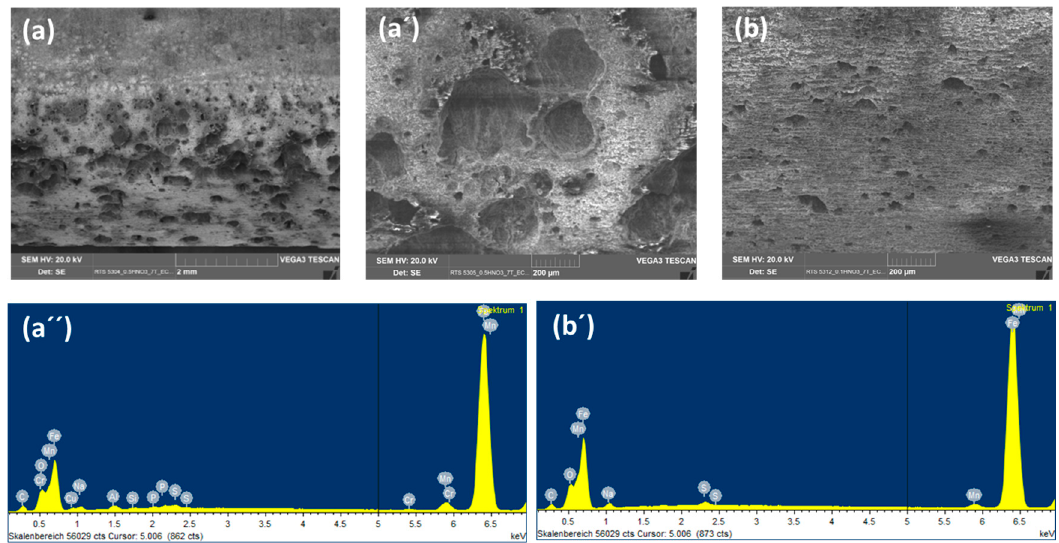
Figure 9. EDS and SEM images of L360NB coupon exposed to the condensates containing 0.114 M H 2 SO 4 and ( a , a’ , a” ) 2 times lower concentration of HNO 3 (9.2 mM) and ( b , b’ ) 10 times lower concentration of HNO 3 (1.84 mM).